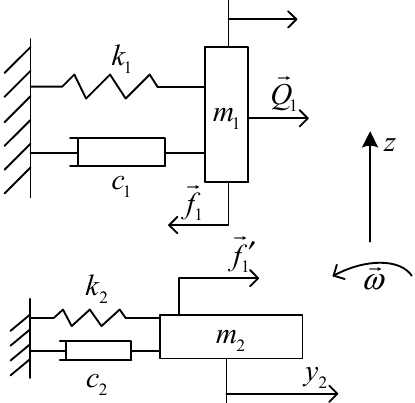
Figure 2. Dynamic model of a blade with an under-platform damper.